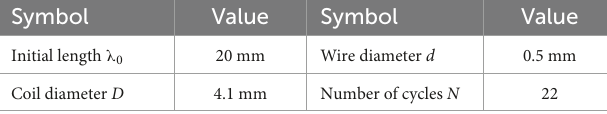
consists of a tension sensor, a temperature sensor, a heating device, a pulley and weights. The actual effect of each factor on SMA springs is determined by experiments, which can provide a reference for improving the working efficiency of SMA actuators. The parameters of SMA springs used in the experiments are shown in Table 2 .